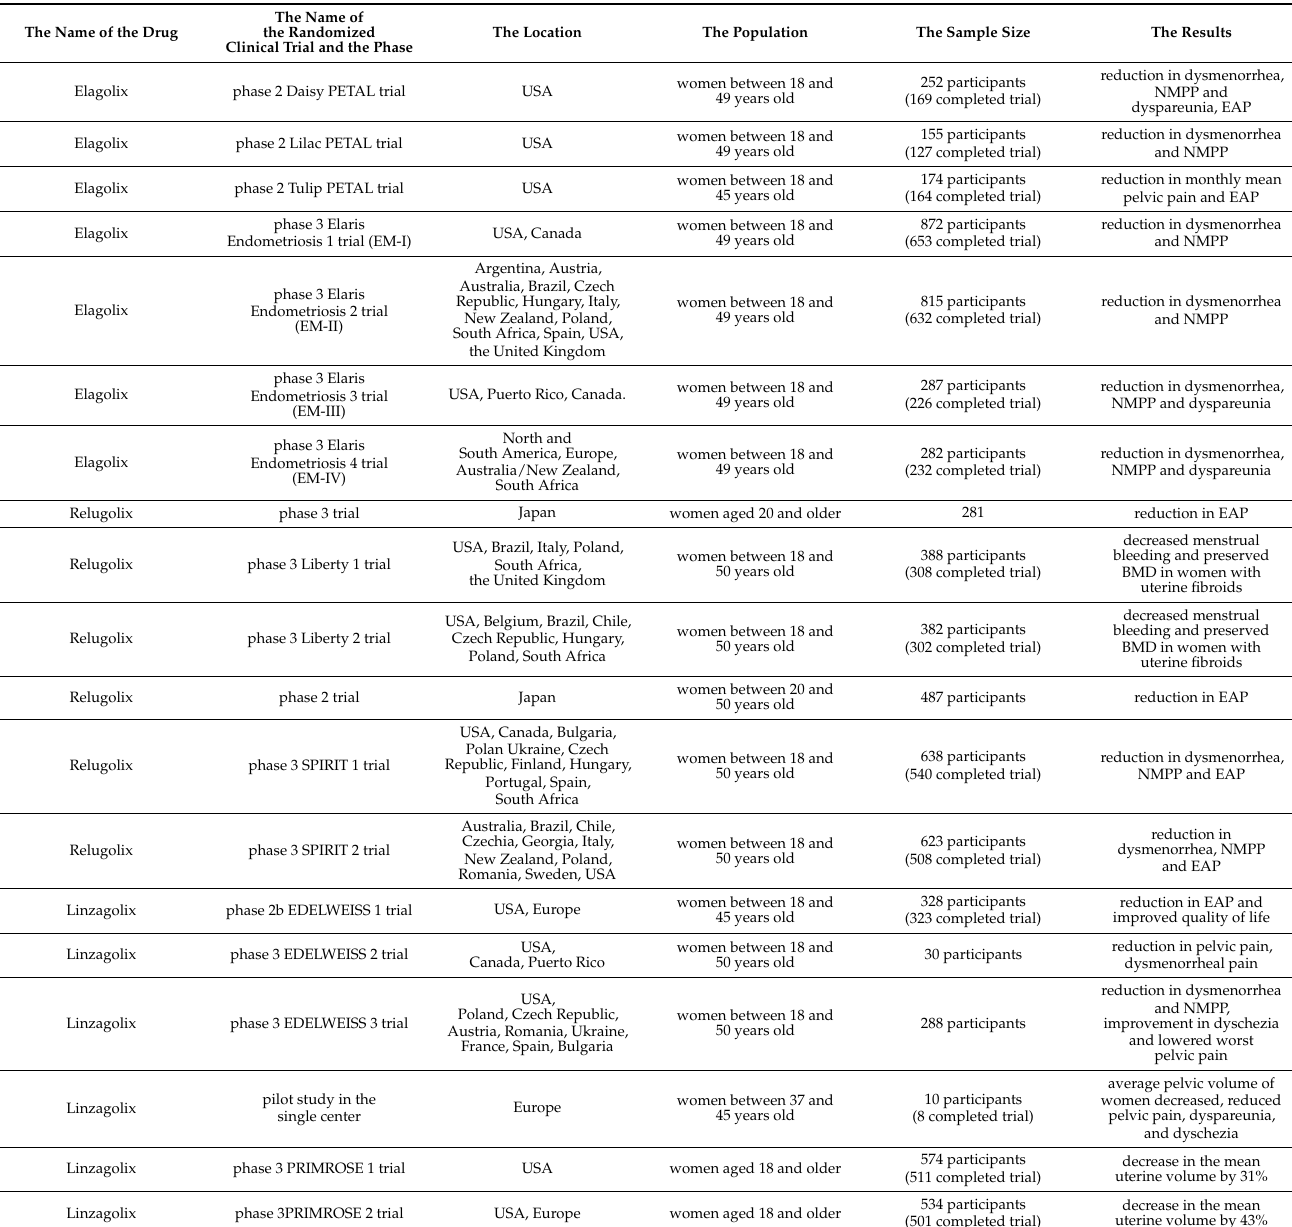
Table 2. The comparison of GnRH antagonists—randomized clinical